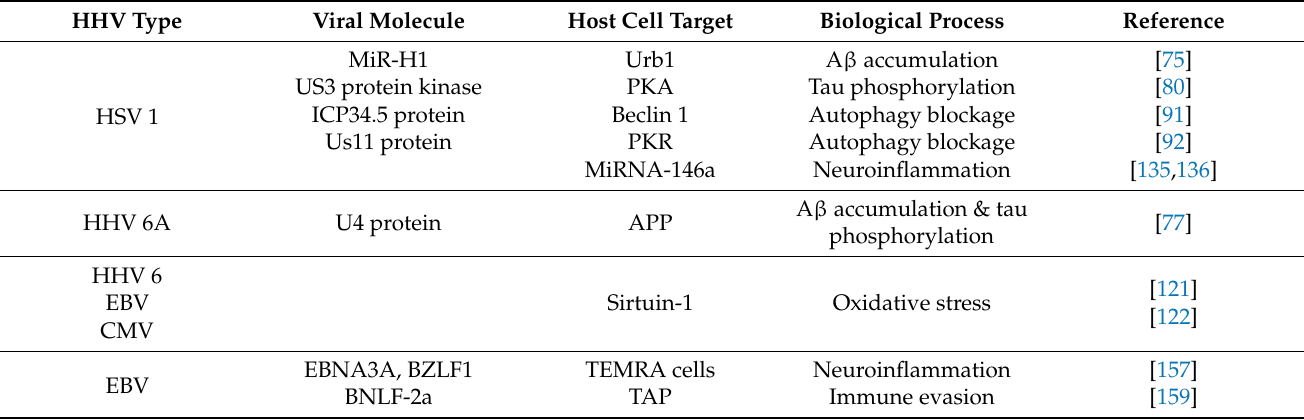
Table 1. HHVs proteins and their targets in neuronal cells within the context of AD